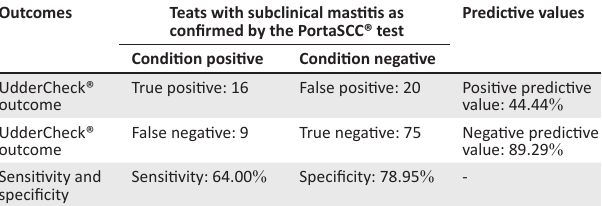
TABLE 3: Cross tabulation of UdderCheck® and PortaSCC®